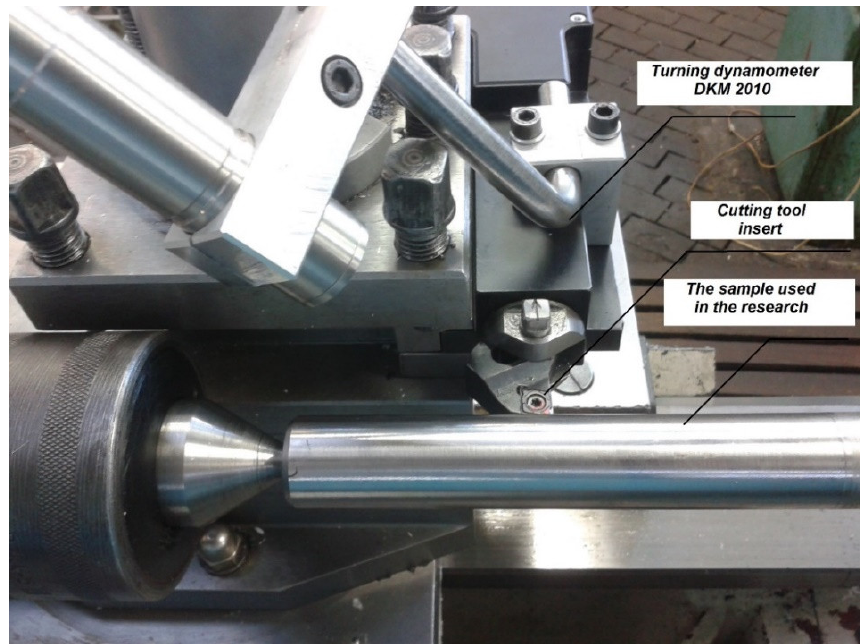
Figure 1. The turning dynamometer DKM 2010 of the outside cylinder surfaces samples in the research and cutting tool insert.